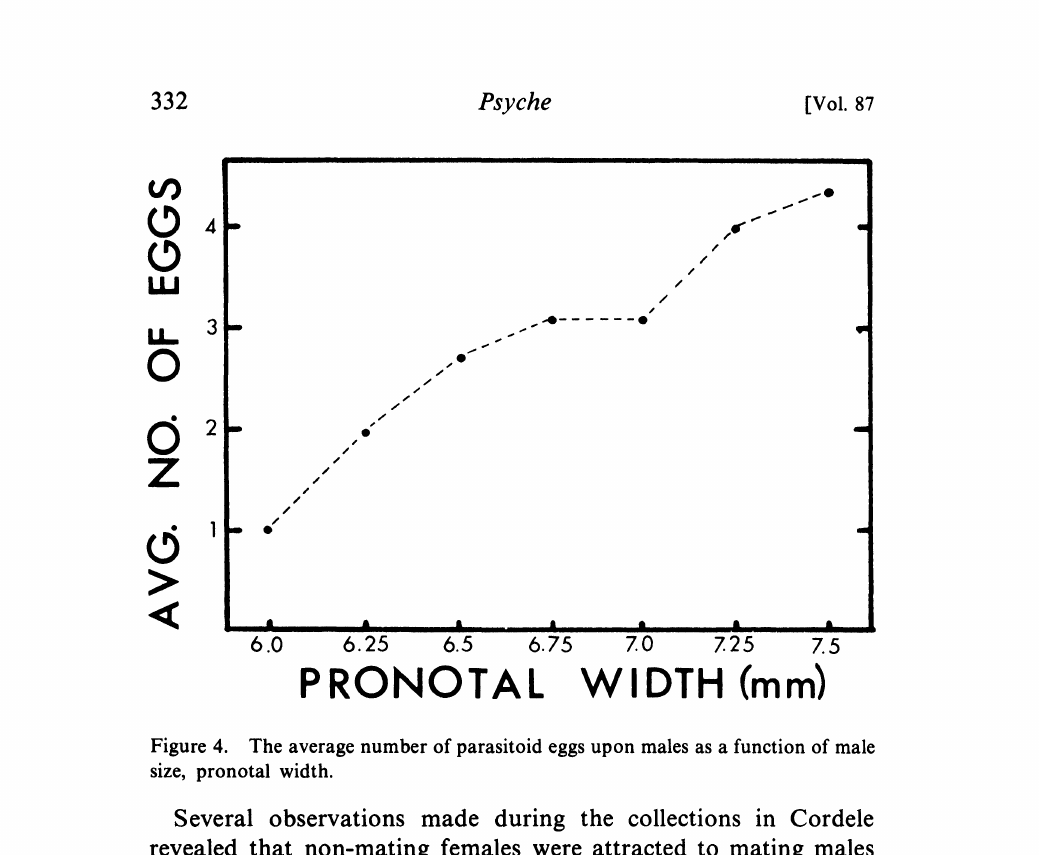
Figure 4. The average number of parasitoid eggs upon males as a function of male size, pronotal